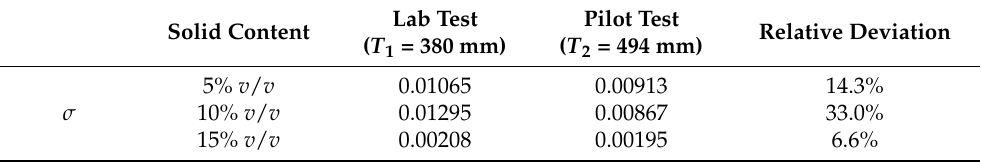
Table 12. The solid uniformity σ before and after scaling up based on the same solid suspension degree. Solid